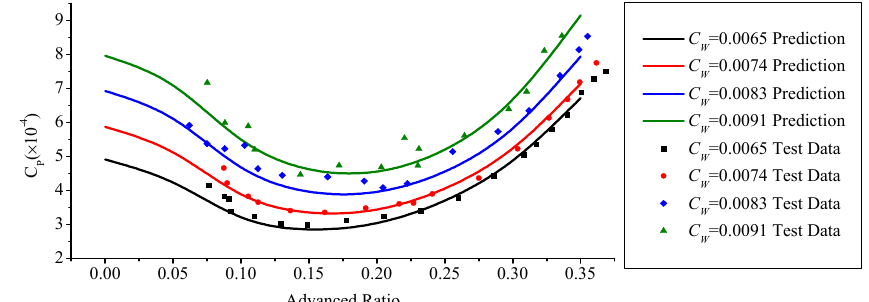
Figure 6. Comparison of the prediction result and flight test data.